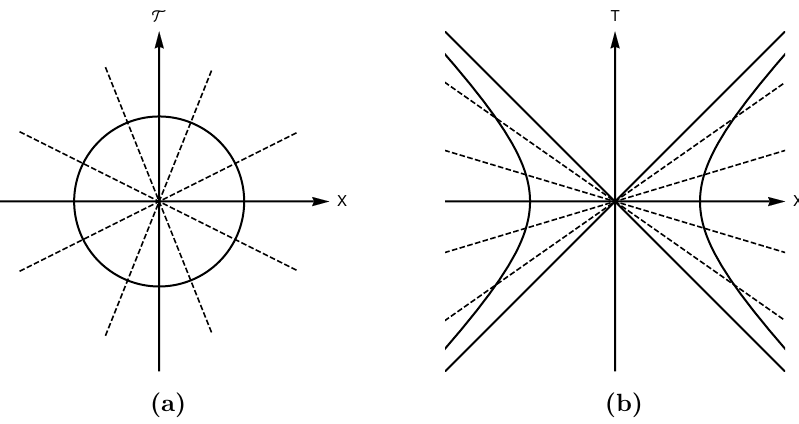
Figure 3. On the left panel is a di(cid:11)erent way to do the foliation of the Euclidean spacetime; the solid circle can represent a typical worldline of an observer in this foliation; the dashed lines (the rays) represent the intermediate spatial slices and con(cid:12)gurations. On the right panel is the corresponding foliation in the Minkowski